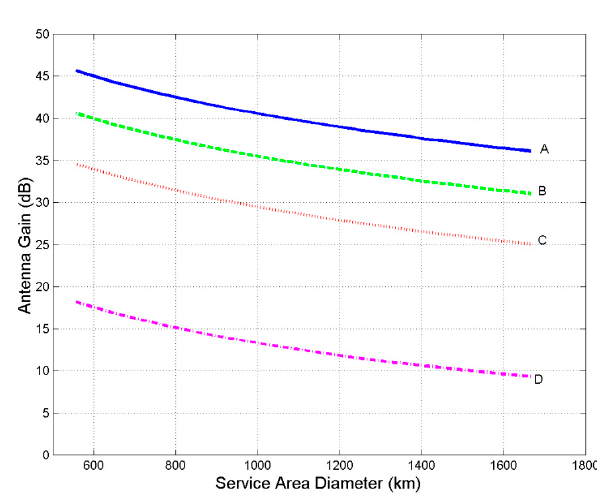
Figure 5. Antenna gain as a function of the service area diameter for the GeoSurf constellation. Antenna efficiency is 0.6. A refers to ℎ = 35,876 km; B to ℎ = 20,000 km; C to ℎ = 10,000 km, D to ℎ = 1500 km.